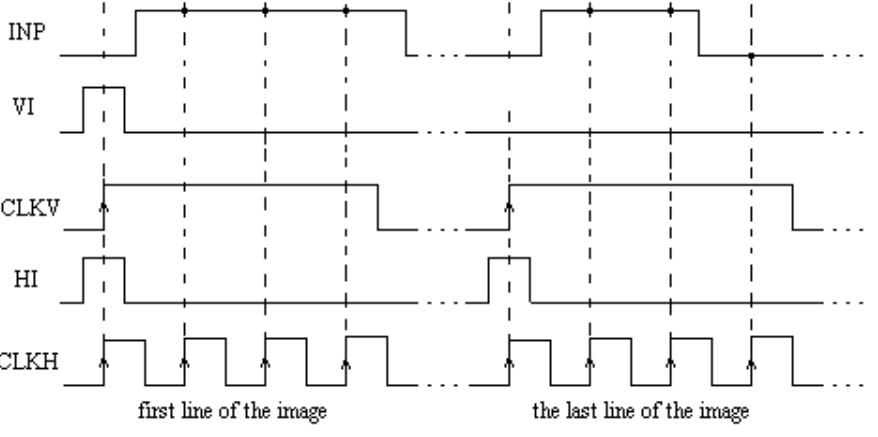
Figure 9. Control signals required for input image loading into a